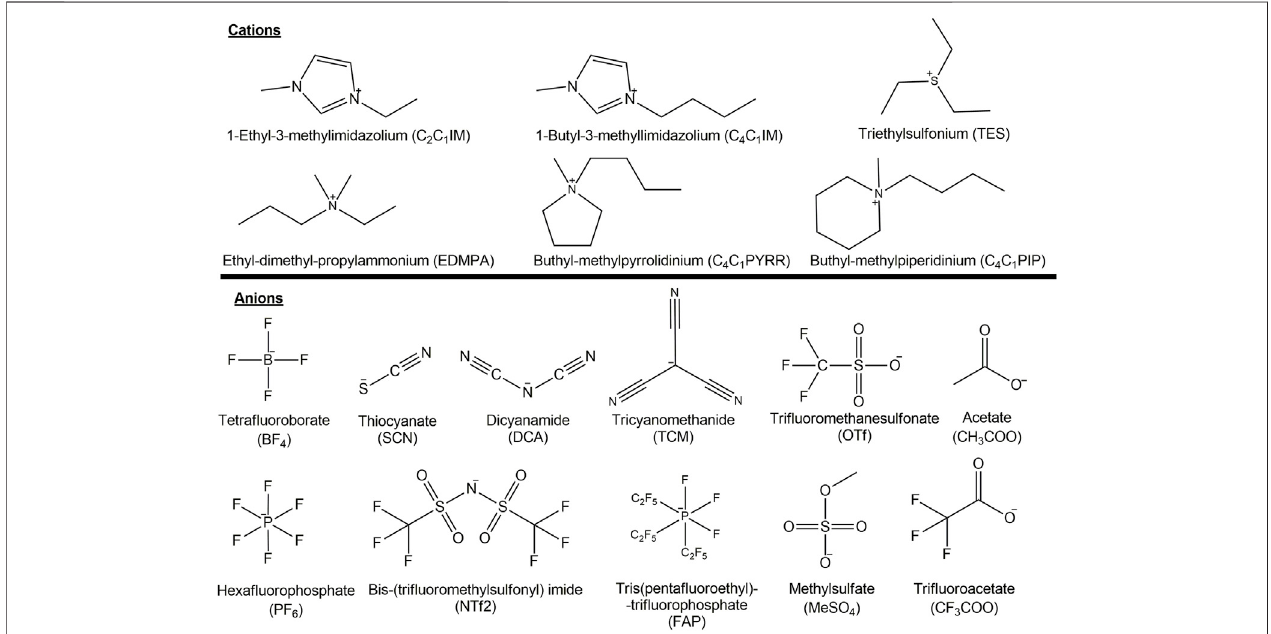
FIGURE 1 | Structures of anions and cations of ionic liquids and the acronyms used in this study.